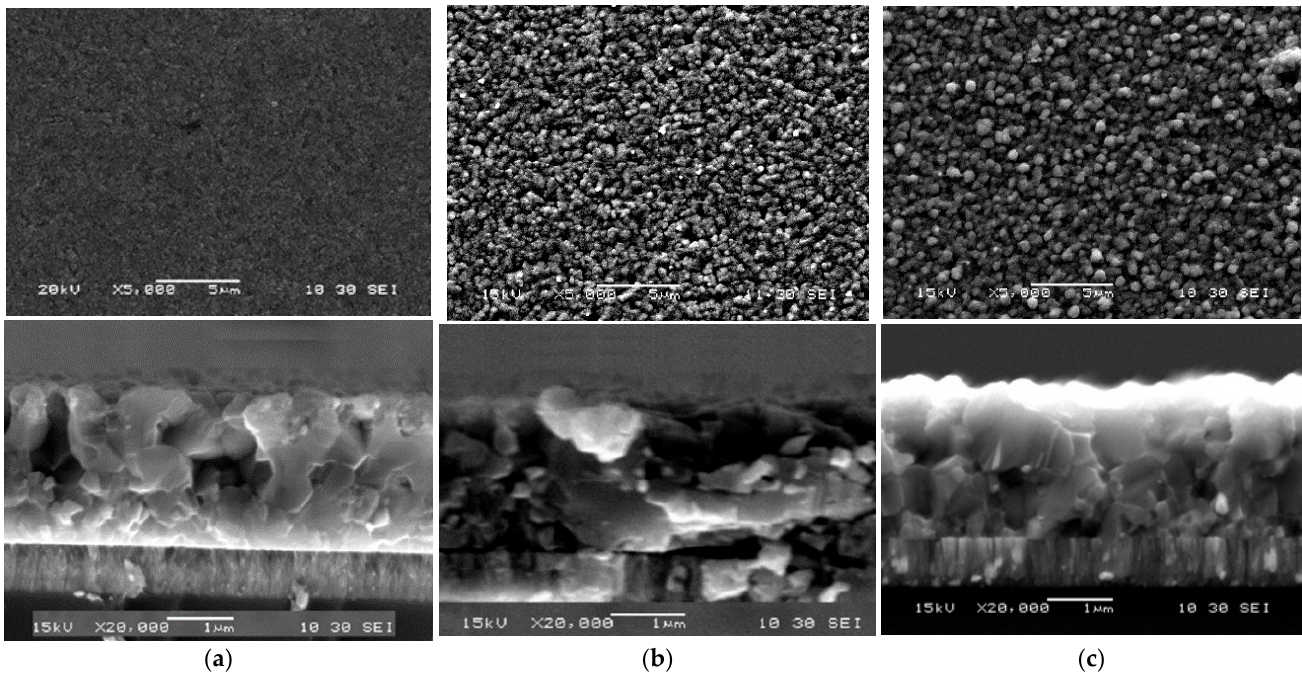
Figure 1. Scanning Electron Microscopy photographs of CIGS films: reference ( a ), second stage LT ( b ) and second stage HT ( c ) recrystallized in a CuCl 2 environment.